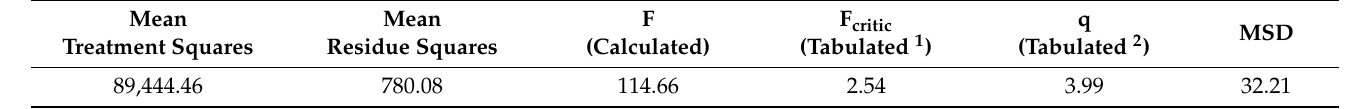
Table 5. ANOVA and Tukey’s test statistical parameters for composite UTS.